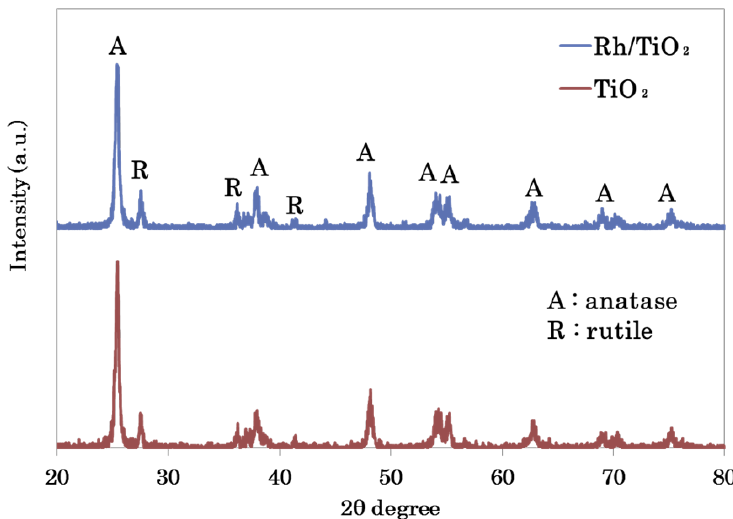
Figure 7. Effect of formate type on photocatalytic hydrogen production with TiO 2 with the aid of simultaneous Rh deposition from various formates (0.265 mol L −1 ) and formic acid (1 wt%) solutions.